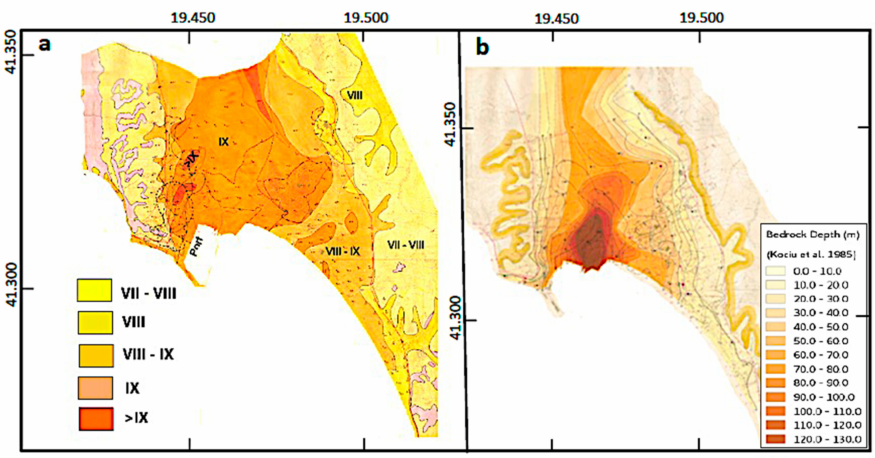
Figure 5. ( a ) Microzoning map for the city of Durres ( b ) iso-depth contours of Durres down to geologic rock formations (modified from